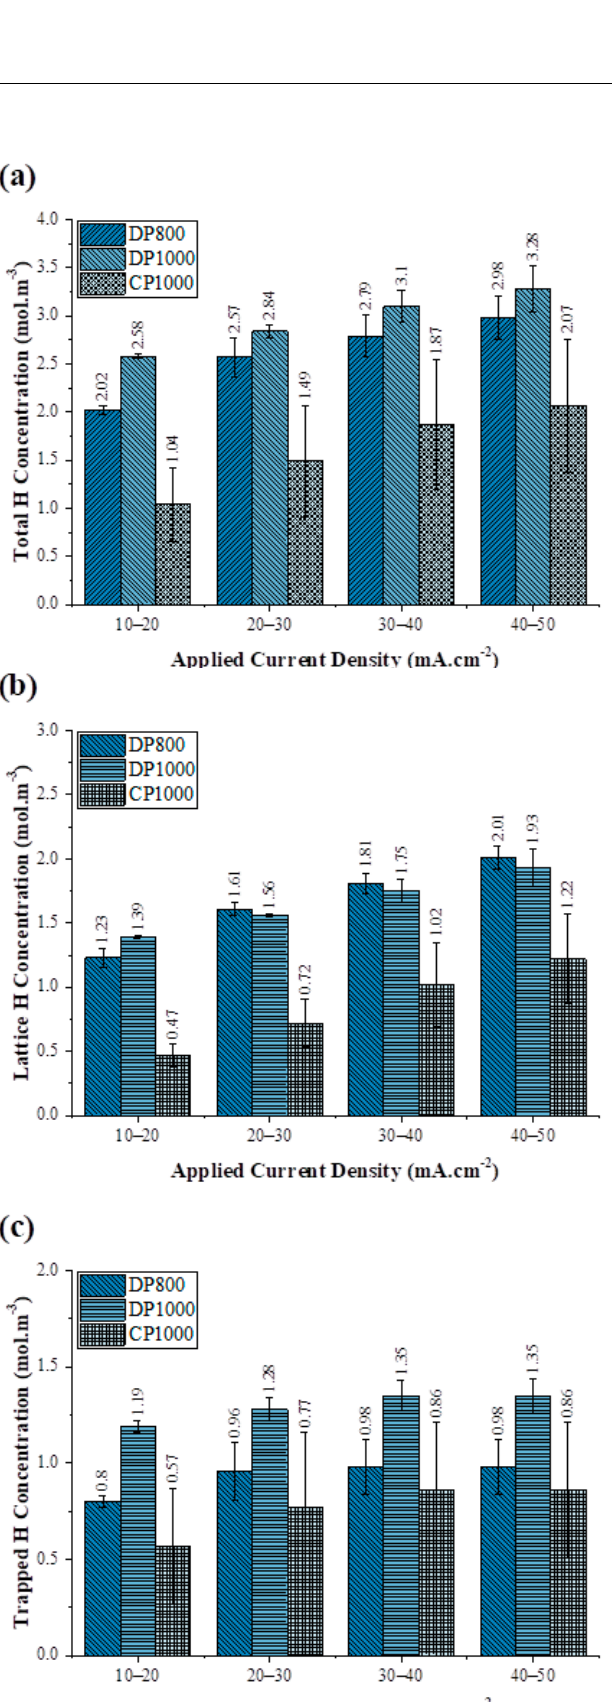
Figure 9. The evolution of ( a ) the total hydrogen concentration at the sub-surface of the charging side, ( b ) the lattice hydrogen concentration at the sub-surface of the charging side, and ( c ) the trapped hydrogen concentration at the sub-surface of the charging side with change in the cathodic current density. Error bars are standard deviation based on two to three